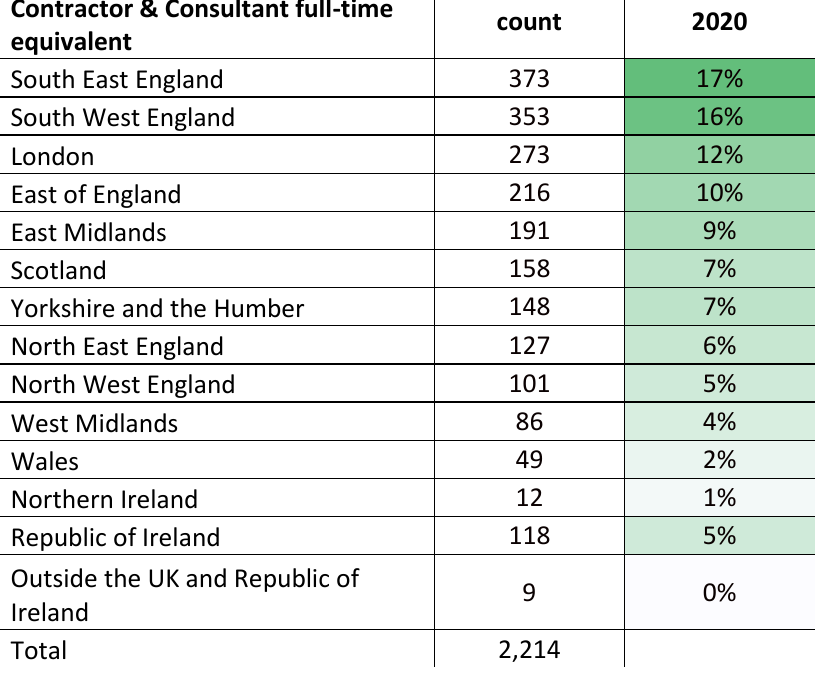
Table 1: Distribution of contractors and consultants by